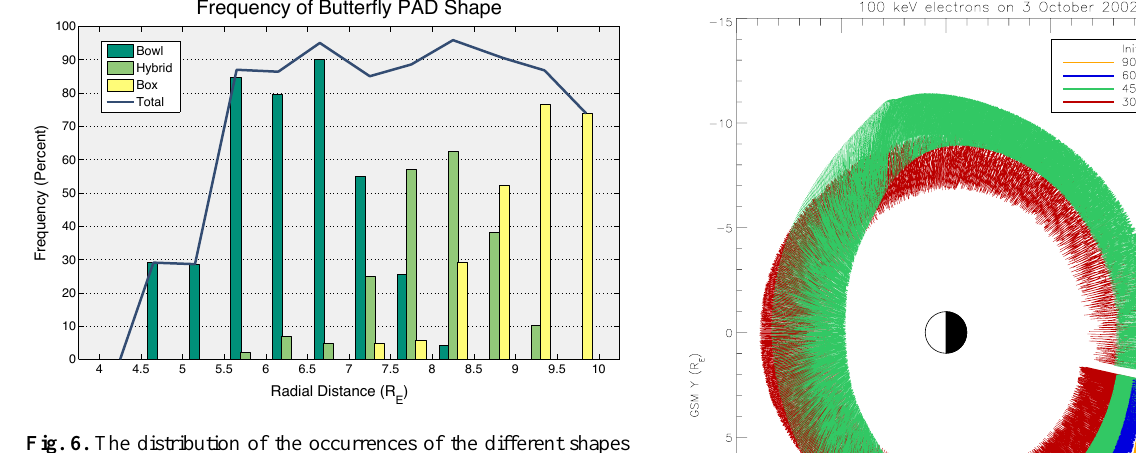
Fig. 6. The distribution of the occurrences of the different shapes of butterfly PAD, according to the radial distance of the magnetic equatorial crossing observed for each event. The distances are sep- arated into 0 . 5 R E bins and counting statistics are taken within.